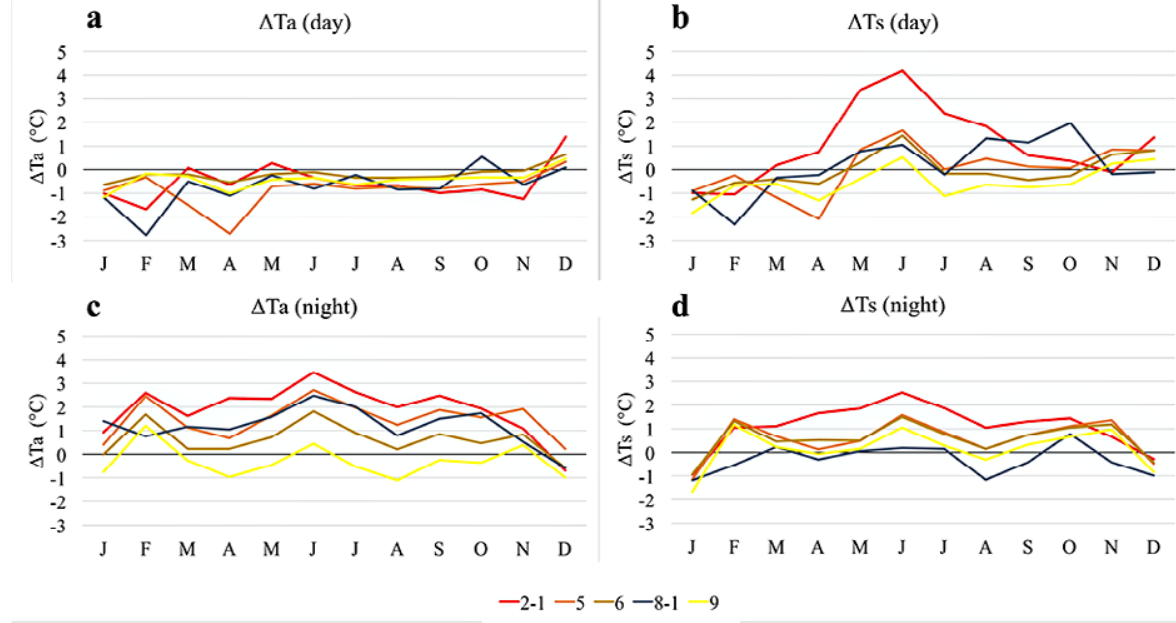
Figure 3. Annual variation of the diurnal (a, b) and nocturnal (c, d) LCZ vs. rural thermal differences detected in surface